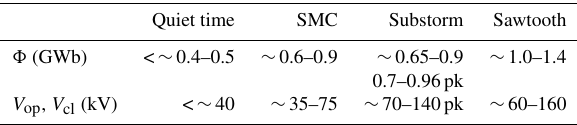
Table 2. Typical values of the open magnetic flux and magnetic reconnection rates estimated during four magnetospheric modes (pk stands for peak values). SMC Substorm